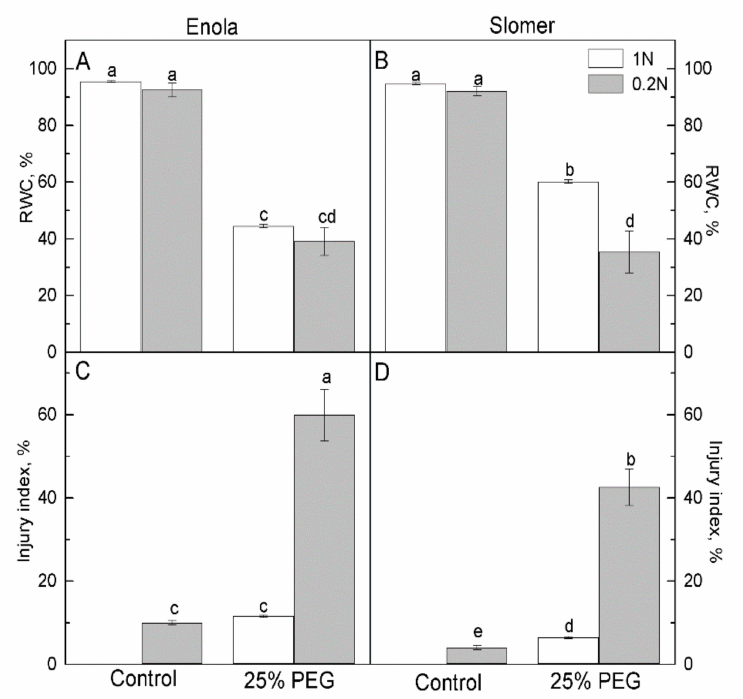
Figure 2. Changes in relative water content (RWC) ( A , B ) and membrane injury index ( C , D ) in leaves of two wheat varieties (Enola and Slomer) grown with optimal (1 N) and reduced (0.2 N) nitrogen supply and subjected to osmotic stress with 25% PEG. Different letters represent significant differences at p < 0.05 ( n =